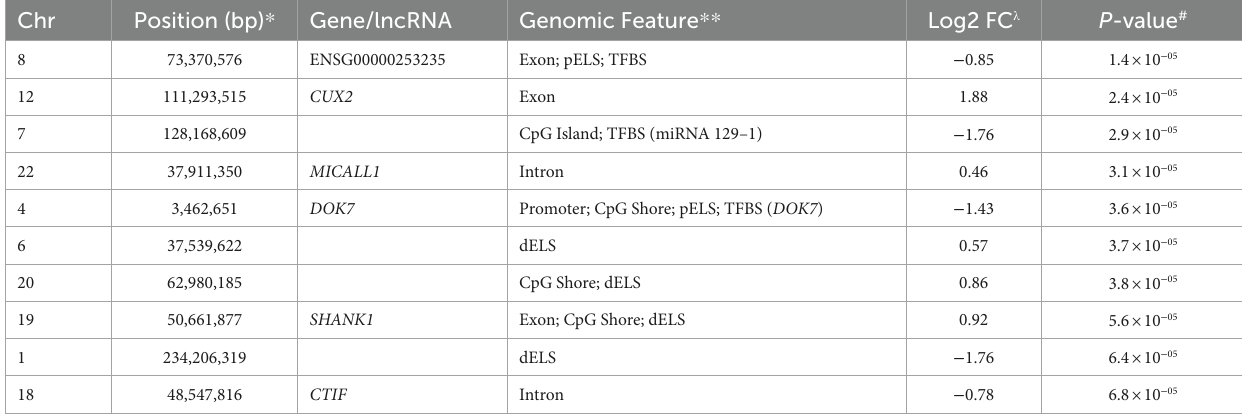
TABLE 4 Top-10 differentiated sites for 5hmC levels in BD case and sib pairs in NSC cell lines. Chr Position (bp) * Gene/lncRNA Genomic Feature ** Log2 FC λ